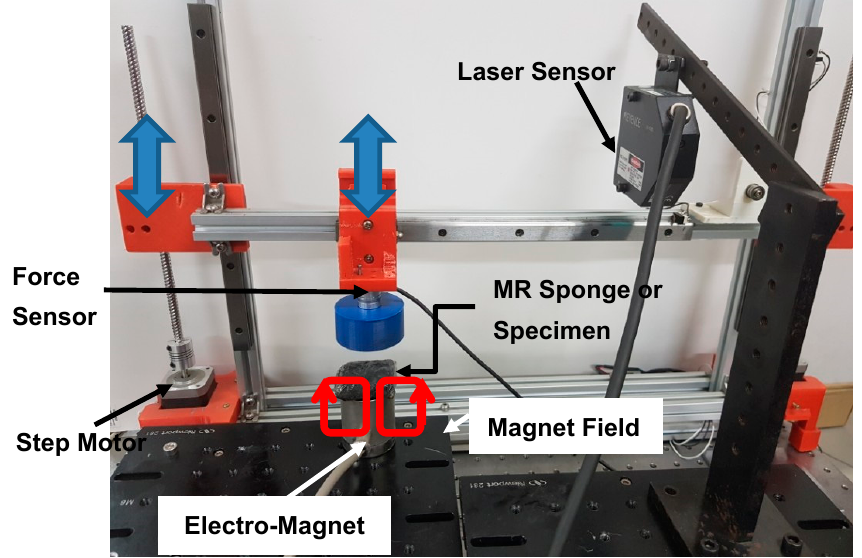
Figure 2. Photograph of force measurement system.